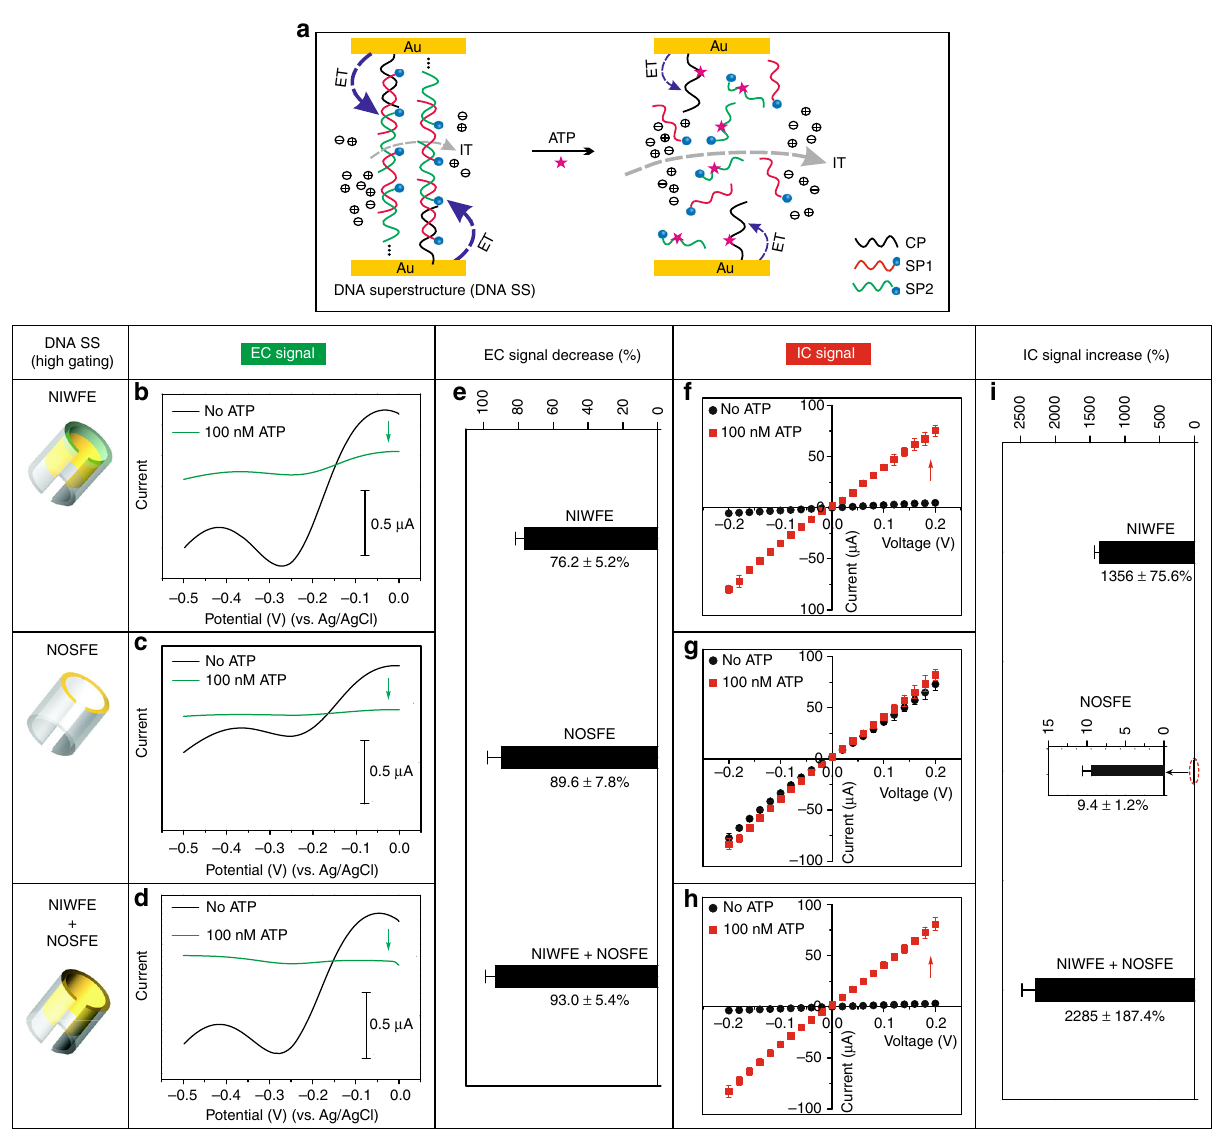
Fig. 3 High-ef fi ciency ion-gating systems probed by dual-current readout. a Schematic of IT (dashed gray arrow) and ET (dashed blue arrow) through double labeling, ATP-responsive, DNA SS-based biomimetic nanochannels. Shown here is the disassembly process at the inner of nanochannels. b – d SWV curves of the assembled DNA SS and the disassembly by ATP at different regions of AAO nanochannels. e Comparison of EC signals changes at the DNA SS-based ATP recognition events. f – h I – V traces of the assembled DNA SS and the disassembly by ATP at different regions of AAO nanochannels. i Comparison of IC signals changes at the DNA SS-based ATP recognition events. Error bars represent standard deviations of independent triple